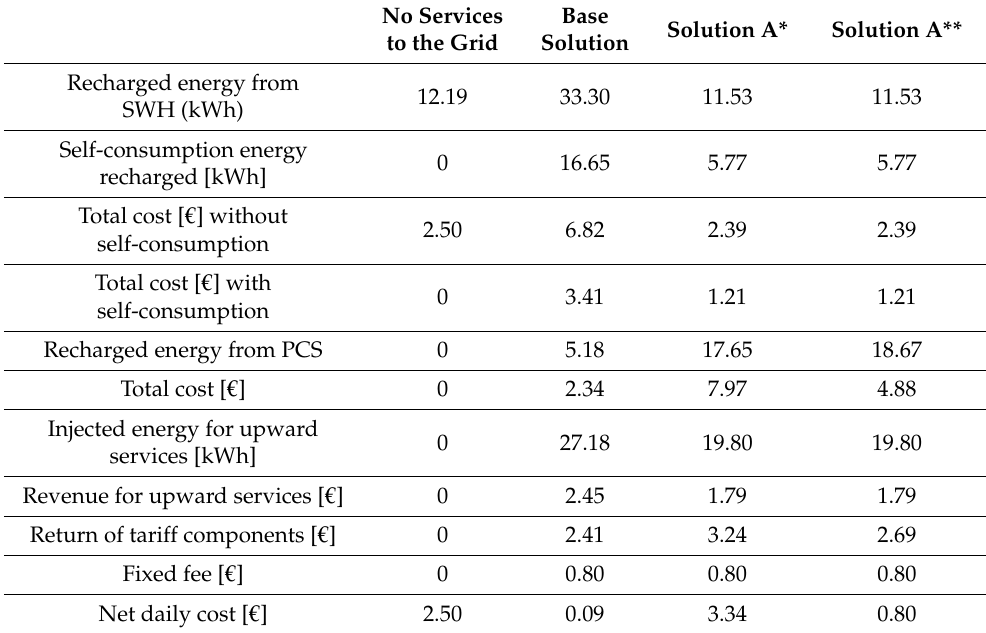
Table 28. Results for mobility pattern 1—UVAMbis (Scenario